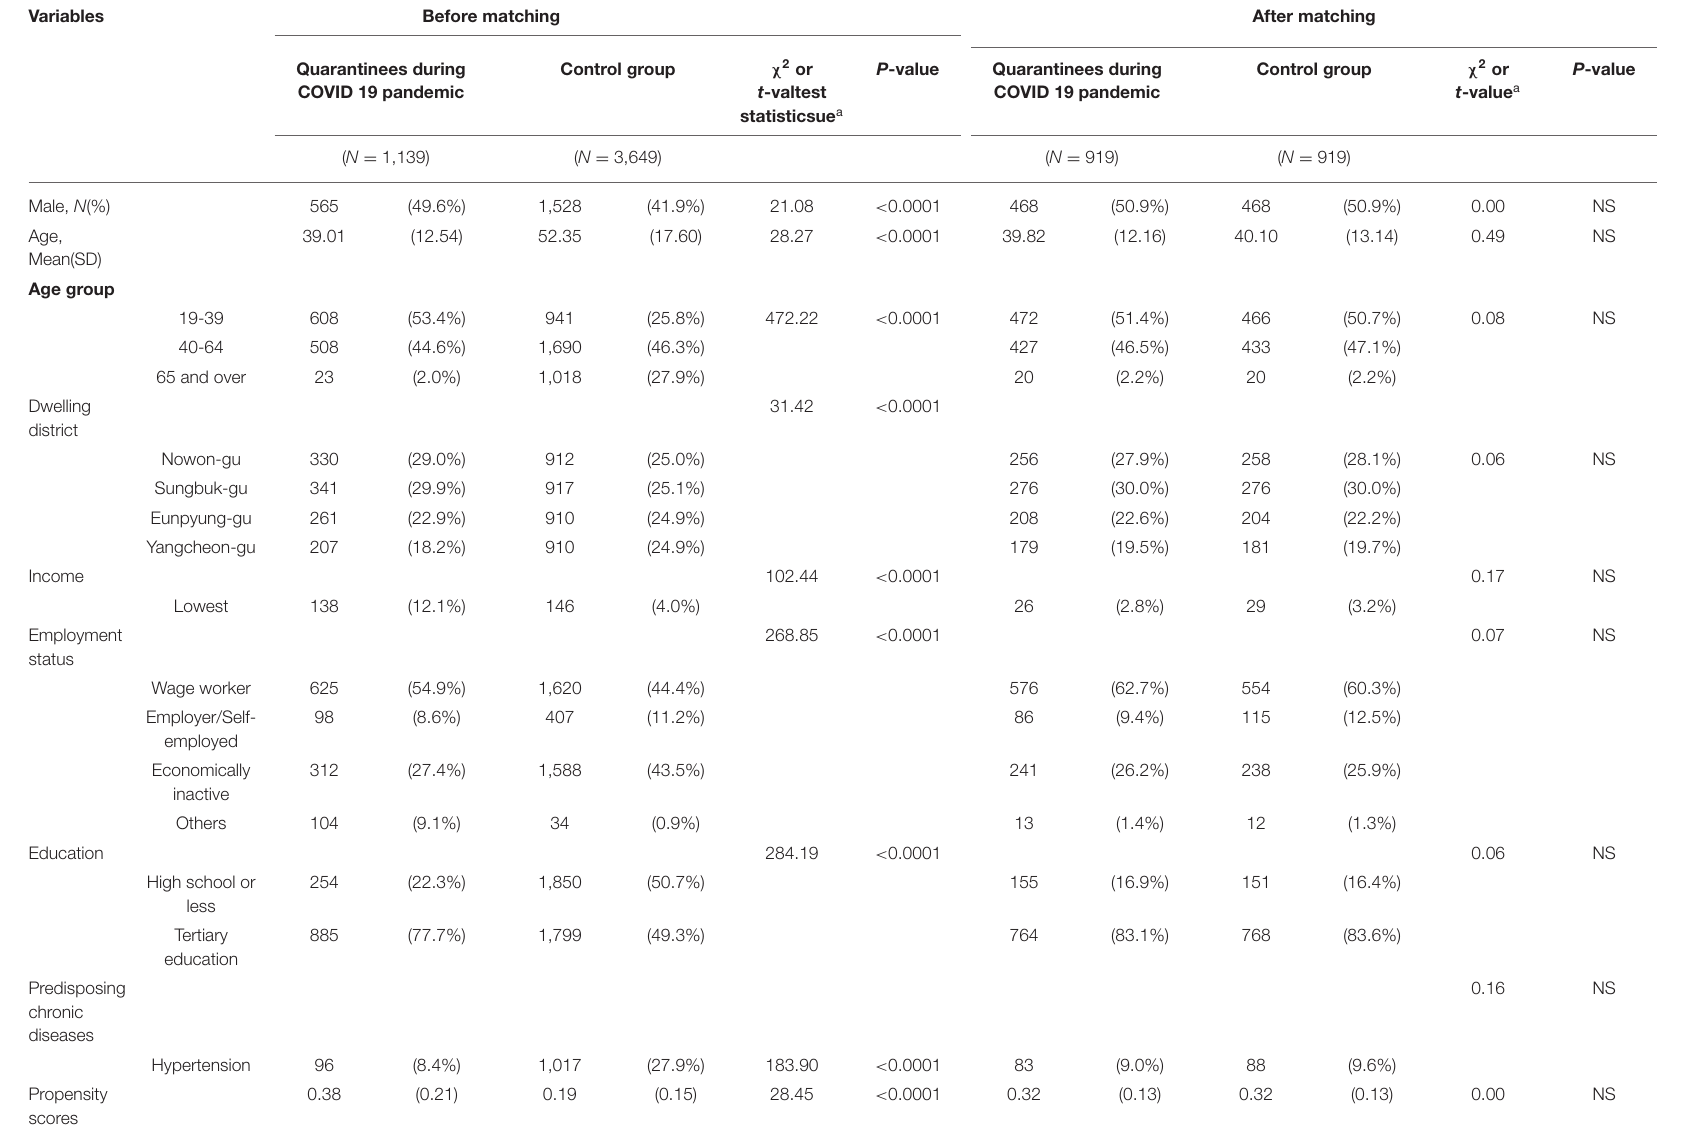
TABLE 1 | Sociodemographic and health-related characteristics of the SCS-Q sample and control group before and after matching.